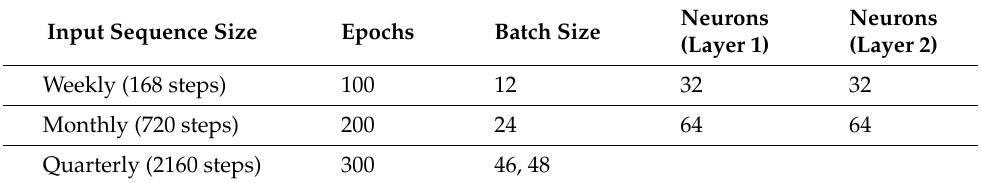
Table 2. Possible parameter configurations for iterative training of stacked LSTM